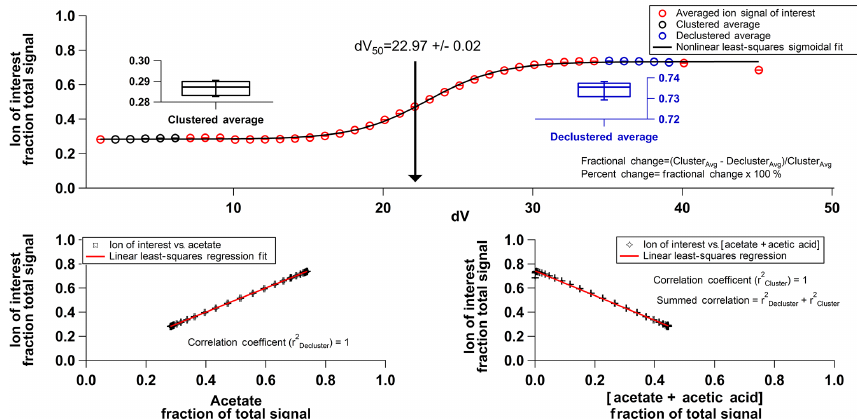
Figure 2. Top panel: an ion of interest is normalized to the total ion signal and plotted against the voltage difference for some component relation (component relation 3 is shown here). The black circles show the portion of the curve used to average the signal of the ion during operation under weak (clustered) electric field strength, with an inset box-and-whisker plot representing the clustered-average. Blue circles show the portion of the curve used to average the signal of the ion during operation under strong (declustered) electric field strength, with an inset box-and-whisker plot representing the declustered-average. The dV 50 value obtained from the nonlinear least-squares sigmoidal fit is also displayed. Bottom: the correlation scatter plots of the ion of interest with acetate and the [acetic acid + acetate] cluster. Linear regression produces an r 2 correlation coefficient for the ion of interest vs. acetate (used as the model for a declustered-deprotonated species) and the ion of interest vs. [acetic acid + acetate]. These two correlation coefficients are summed and used as criteria for including or excluding declustering